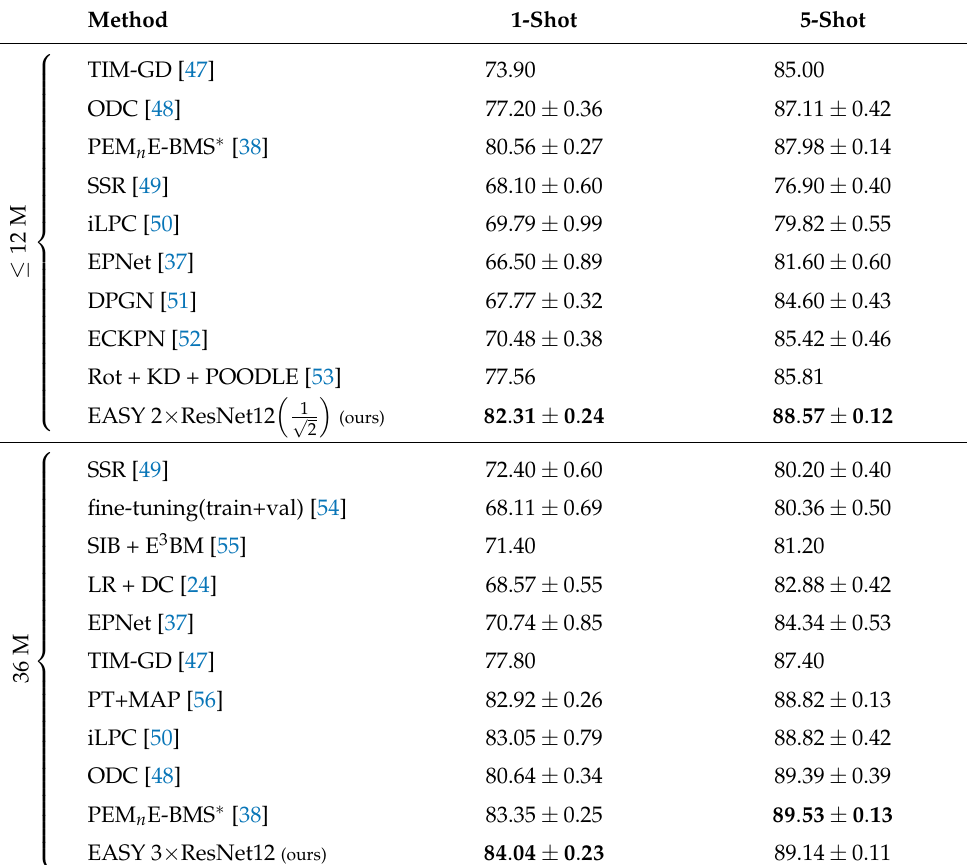
Table 6. The 1-shot and 5-shot accuracy of state-of-the-art methods and the proposed solution on MiniImageNet in the transductive